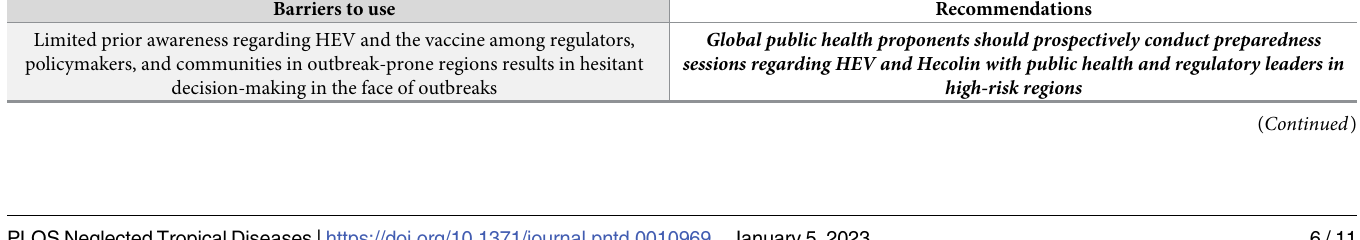
Table 1. Summary of barriers to use and recommendations. Barriers to